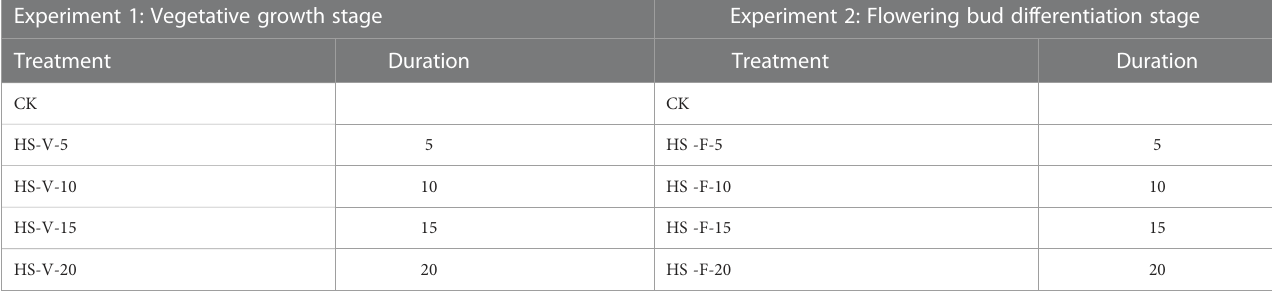
TABLE 1 Experimental design of heat stress under two growth stages. V and F indicate the vegetative growth stage and fl owering bud differentiation stage. Experiment 1: Vegetative growth stage Experiment 2: Flowering bud differentiation